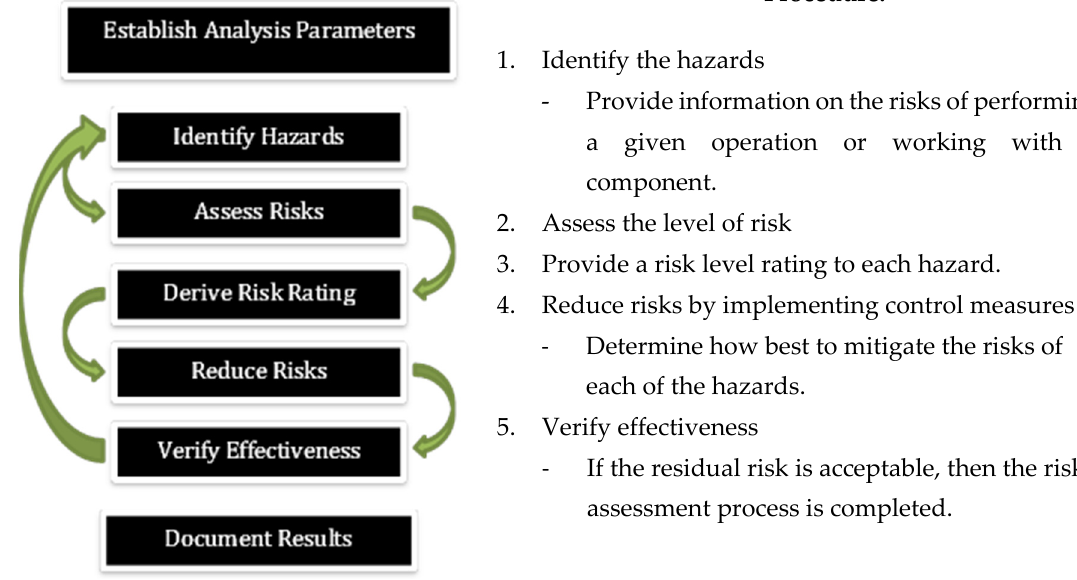
Figure 5. Process for completing a Hazard Analysis and Risk Assessment (HARA) [10].